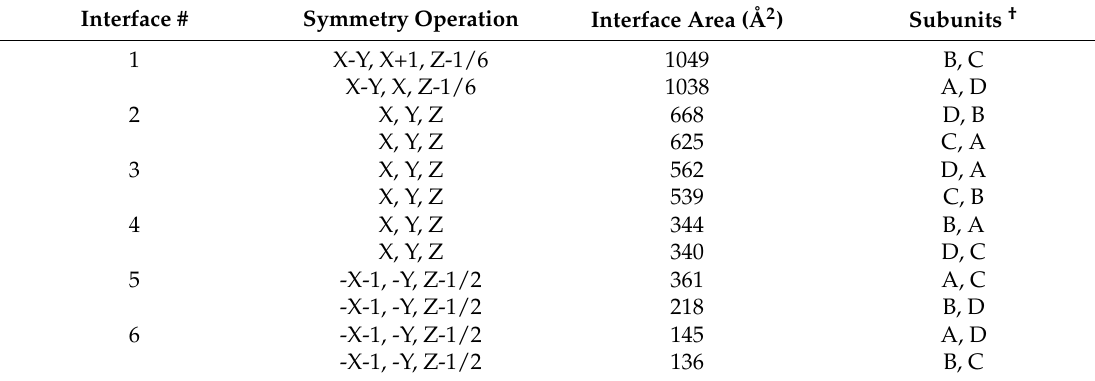
Table 5. Crystallographic interfaces for unliganded α-chymotrypsin in space group P6 5 .